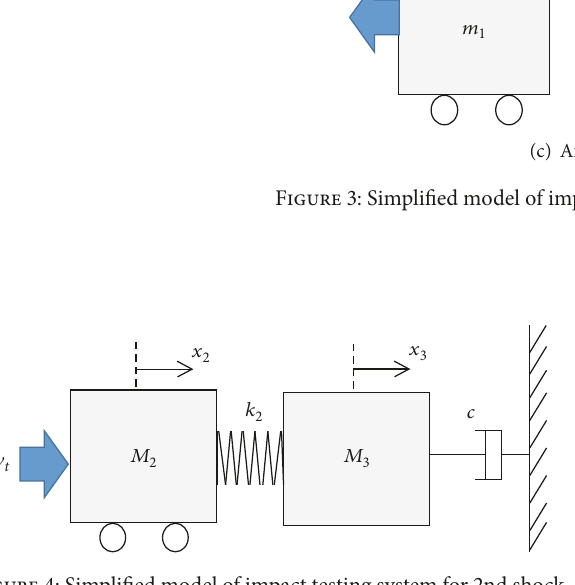
Figure 4: Simplified model of impact testing system for 2nd shock-